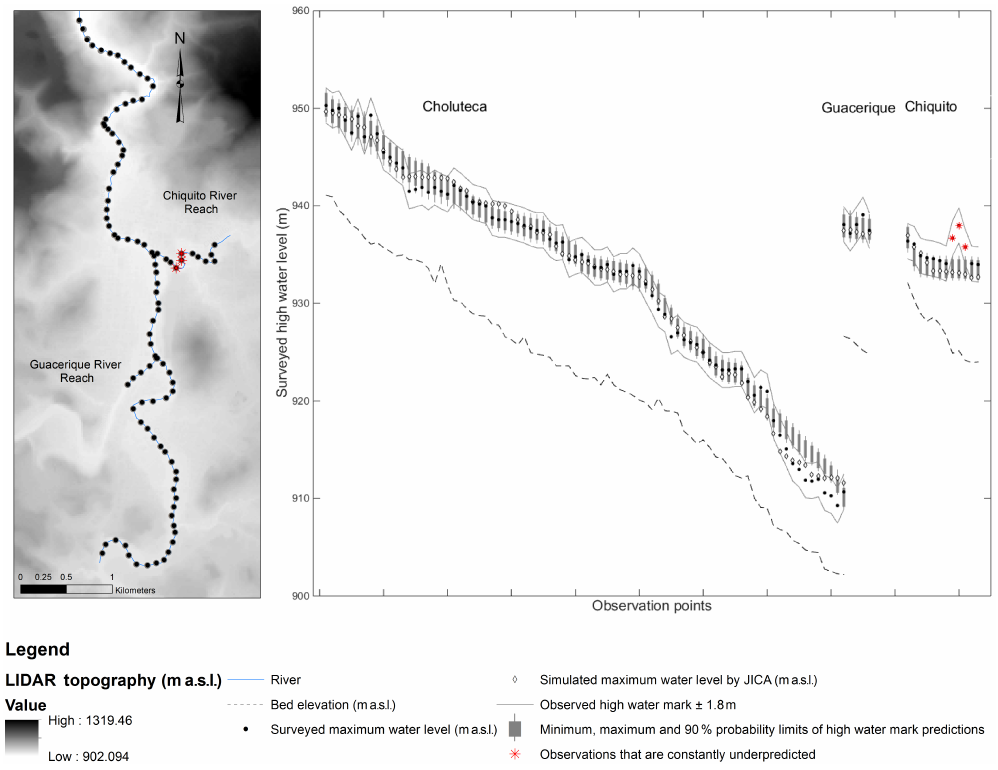
Figure 11. Likelihood of high-water marks during the Mitch event, considering uncertainty in model parameters, model input, and evaluation data to drive and constrain a combination of rainfall–runoff and hydraulic modelling